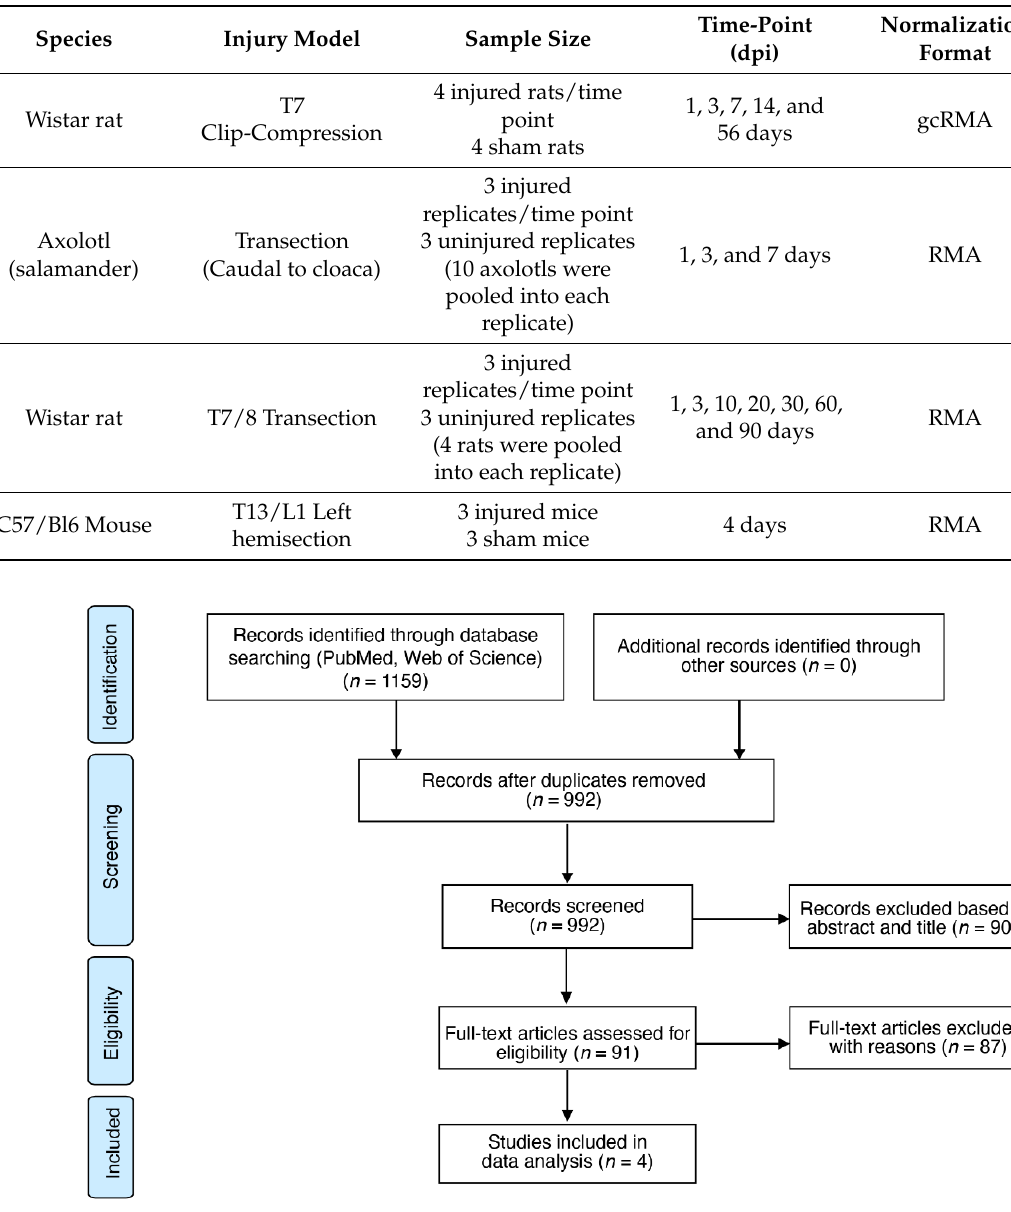
Table 1. Summary of the four cross-compatible microarray studies.